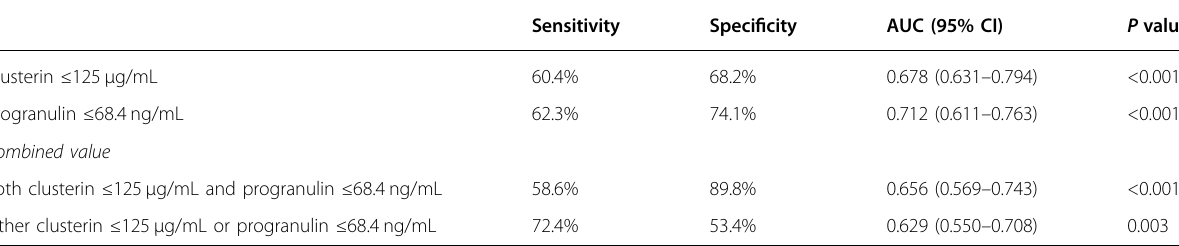
CI con fi dence interval, ROC receiver operating characteristic, AUC area under the